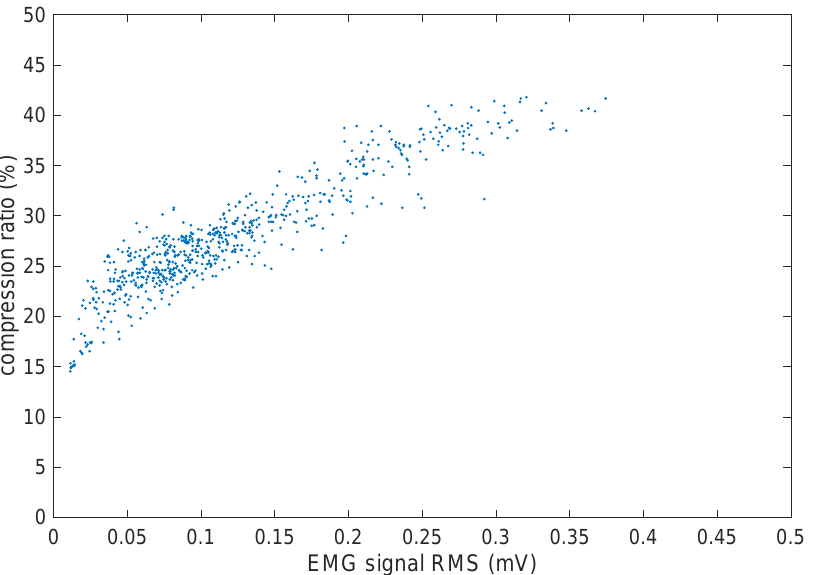
Figure 12. Scatter plot of the compression ratio vs. EMG signal strength (average RMS value of the three channels, as FLAC compresses them together into a single